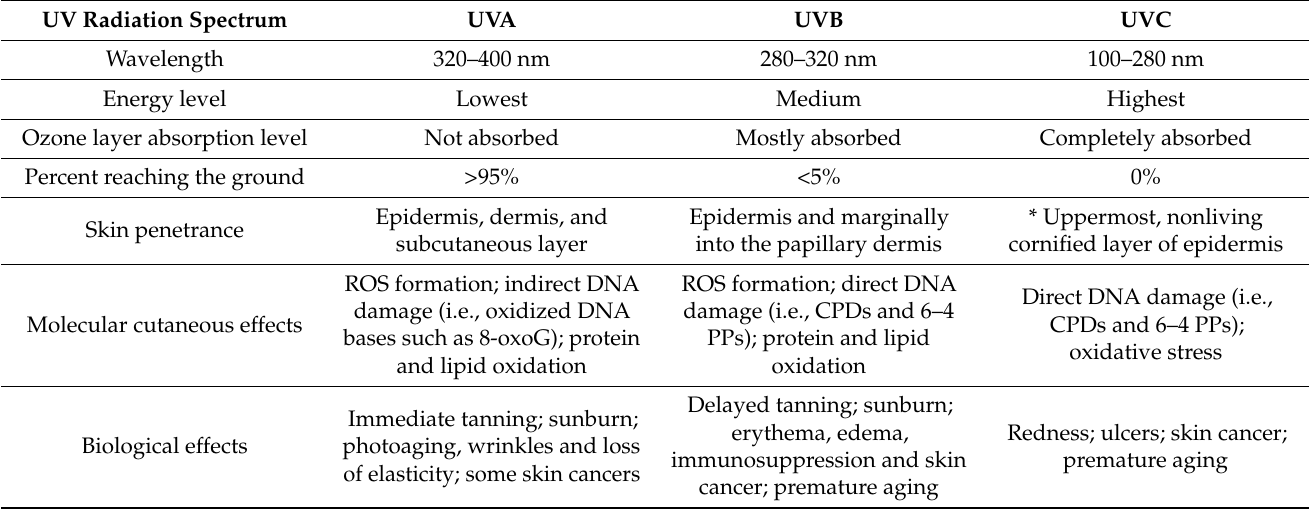
Table 1. Different types of UV rays and their